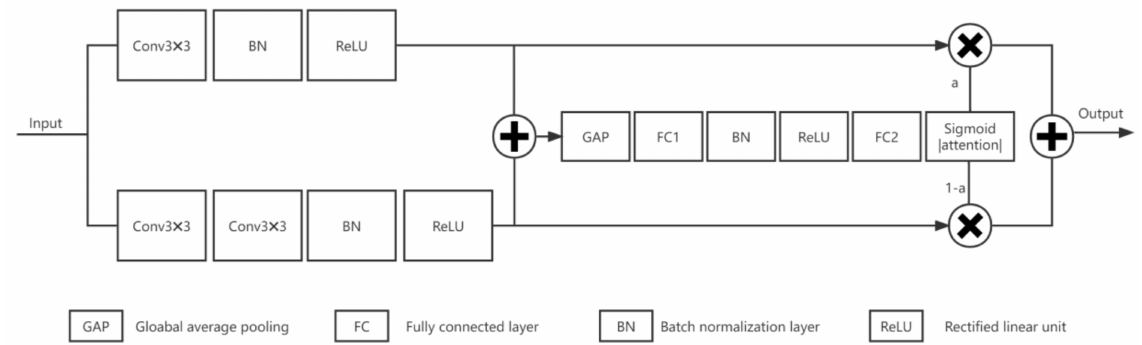
Figure 4. Schematic diagram of the structure of the proposed defect segmentation network. SK block is adopted instead of convolutional block with an attention gate.